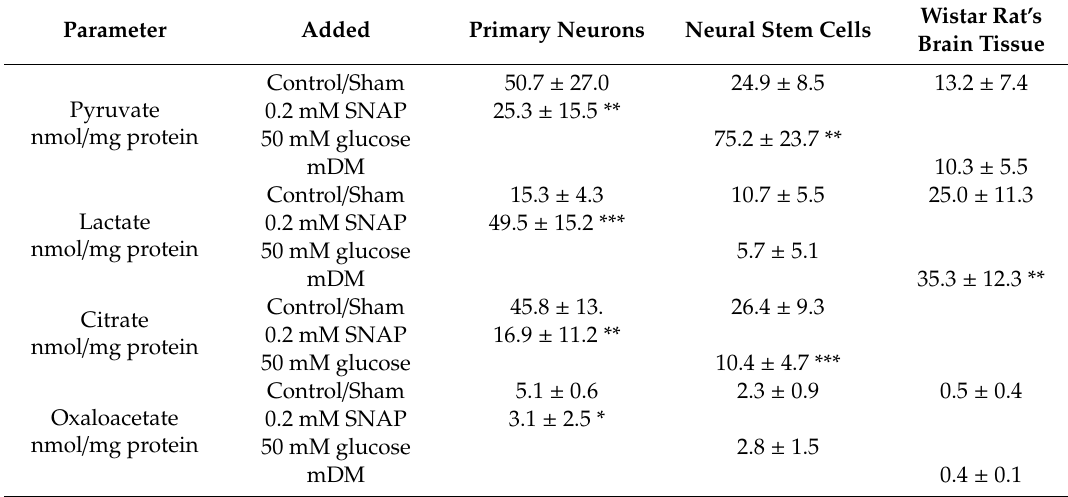
Table 2. Metabolite levels measured in Wistar rat